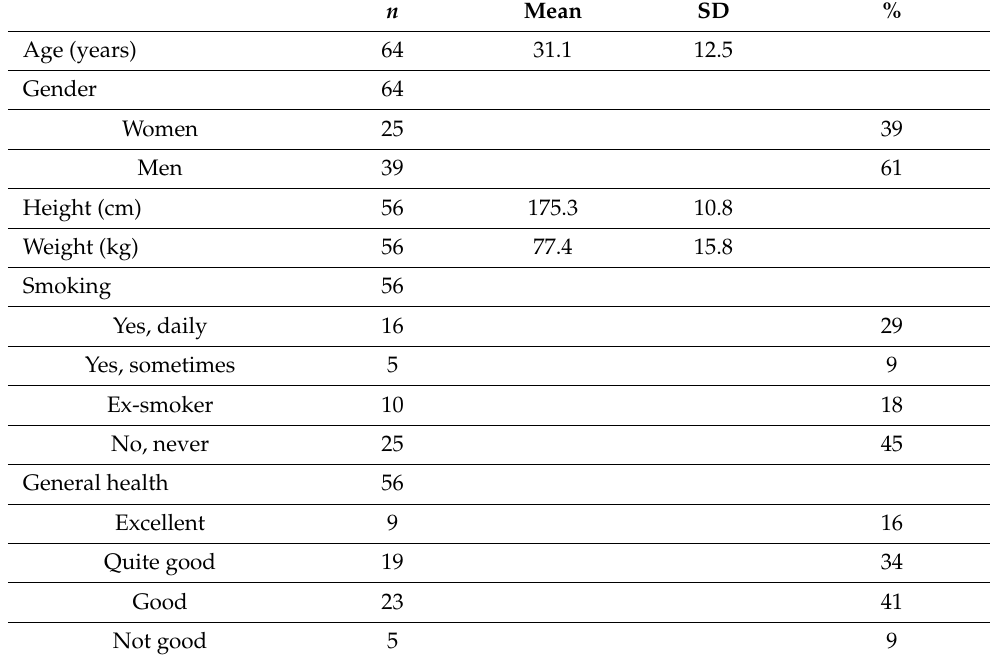
Table 1. Participant